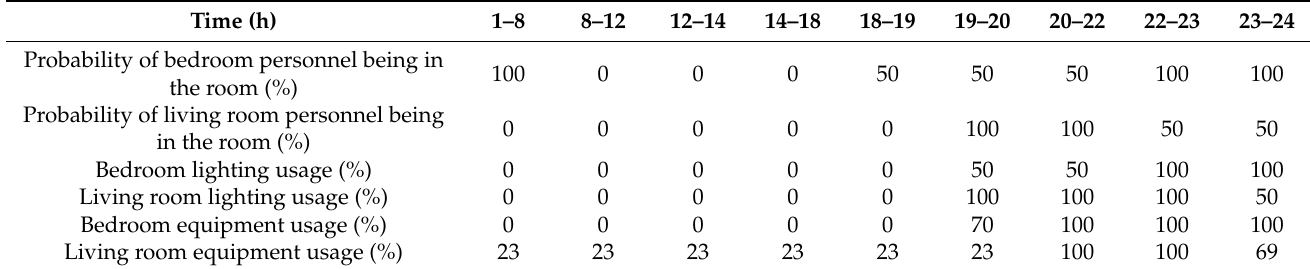
Table 4. Setting of design parameters for residential building (type 2).